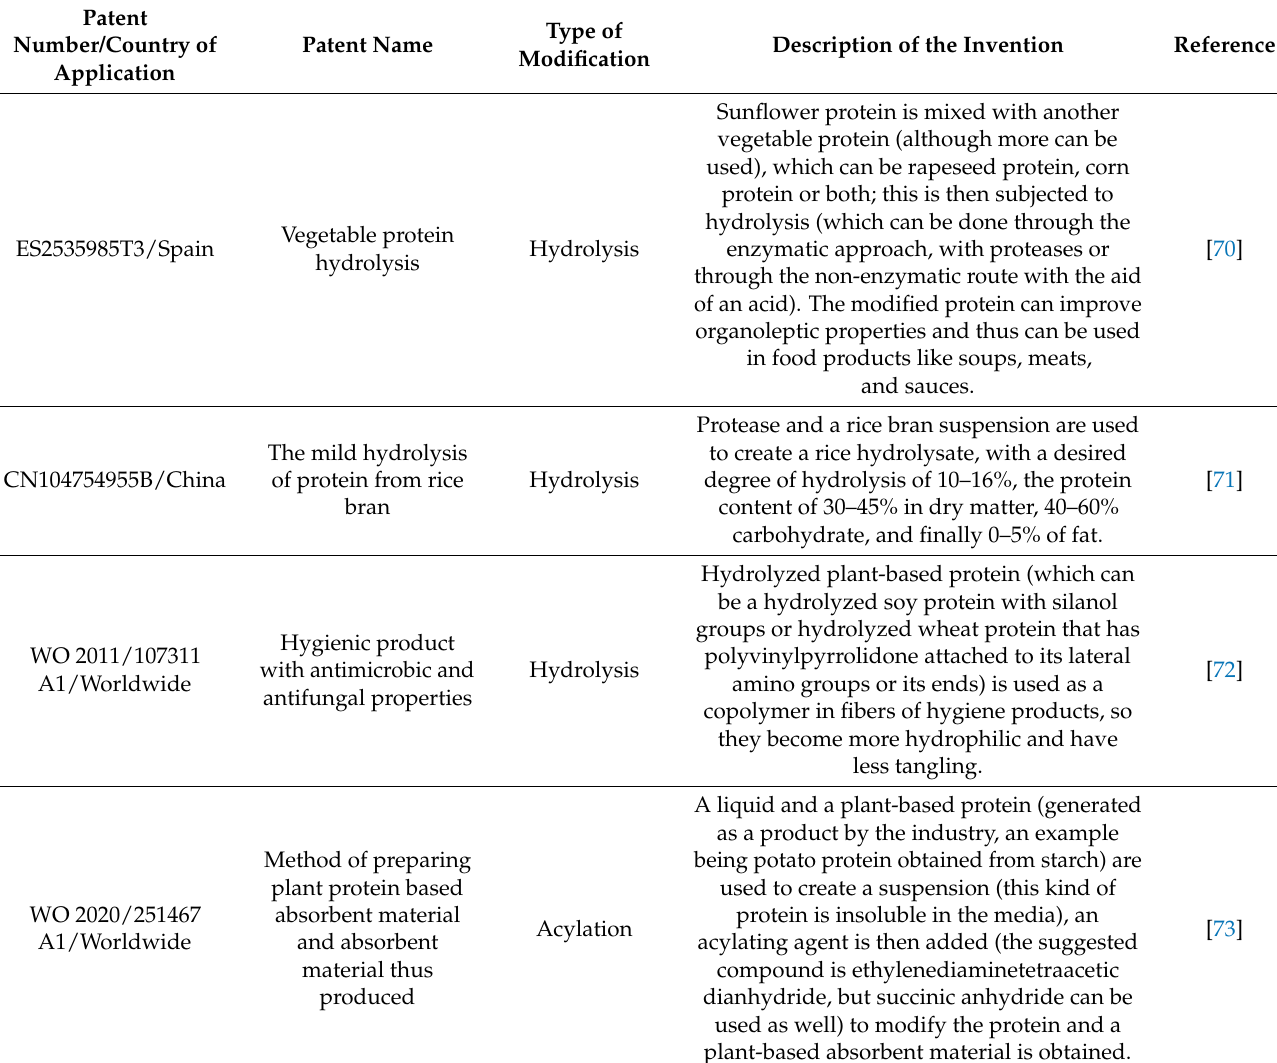
Table 2. Patents associated with the production of plant-based